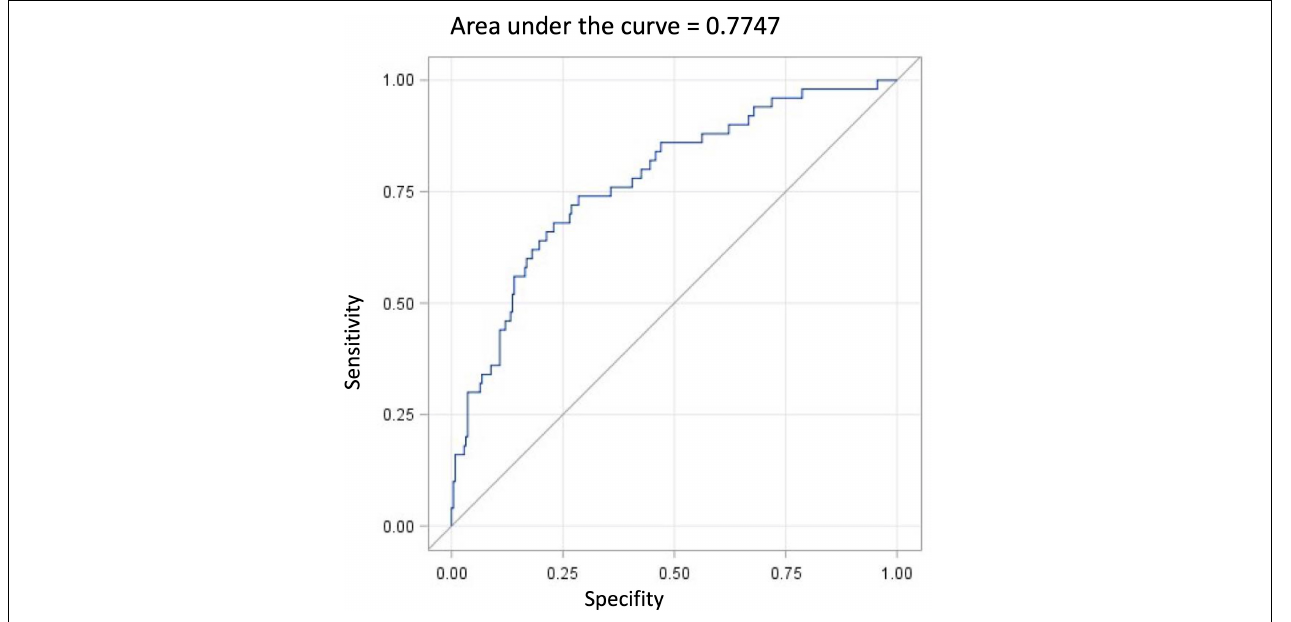
FIGURE 3 | Receiver operating characteristic (ROC) curve of logistic regression